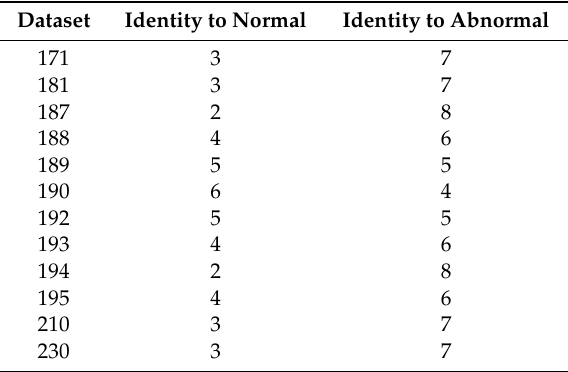
Table 8. Recognition results for springs of all